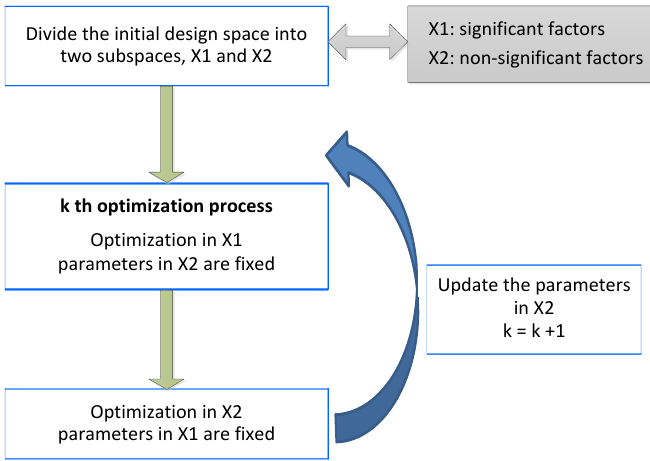
Figure 7. Main flowchart for multi-level optimization method.